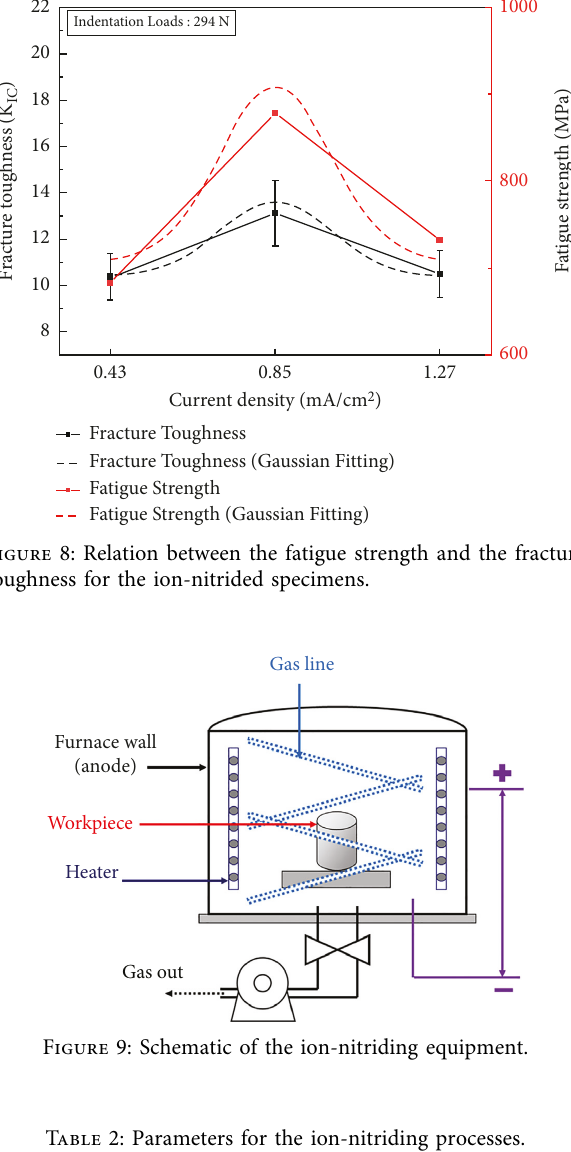
Table 2: Parameters for the ion-nitriding processes.